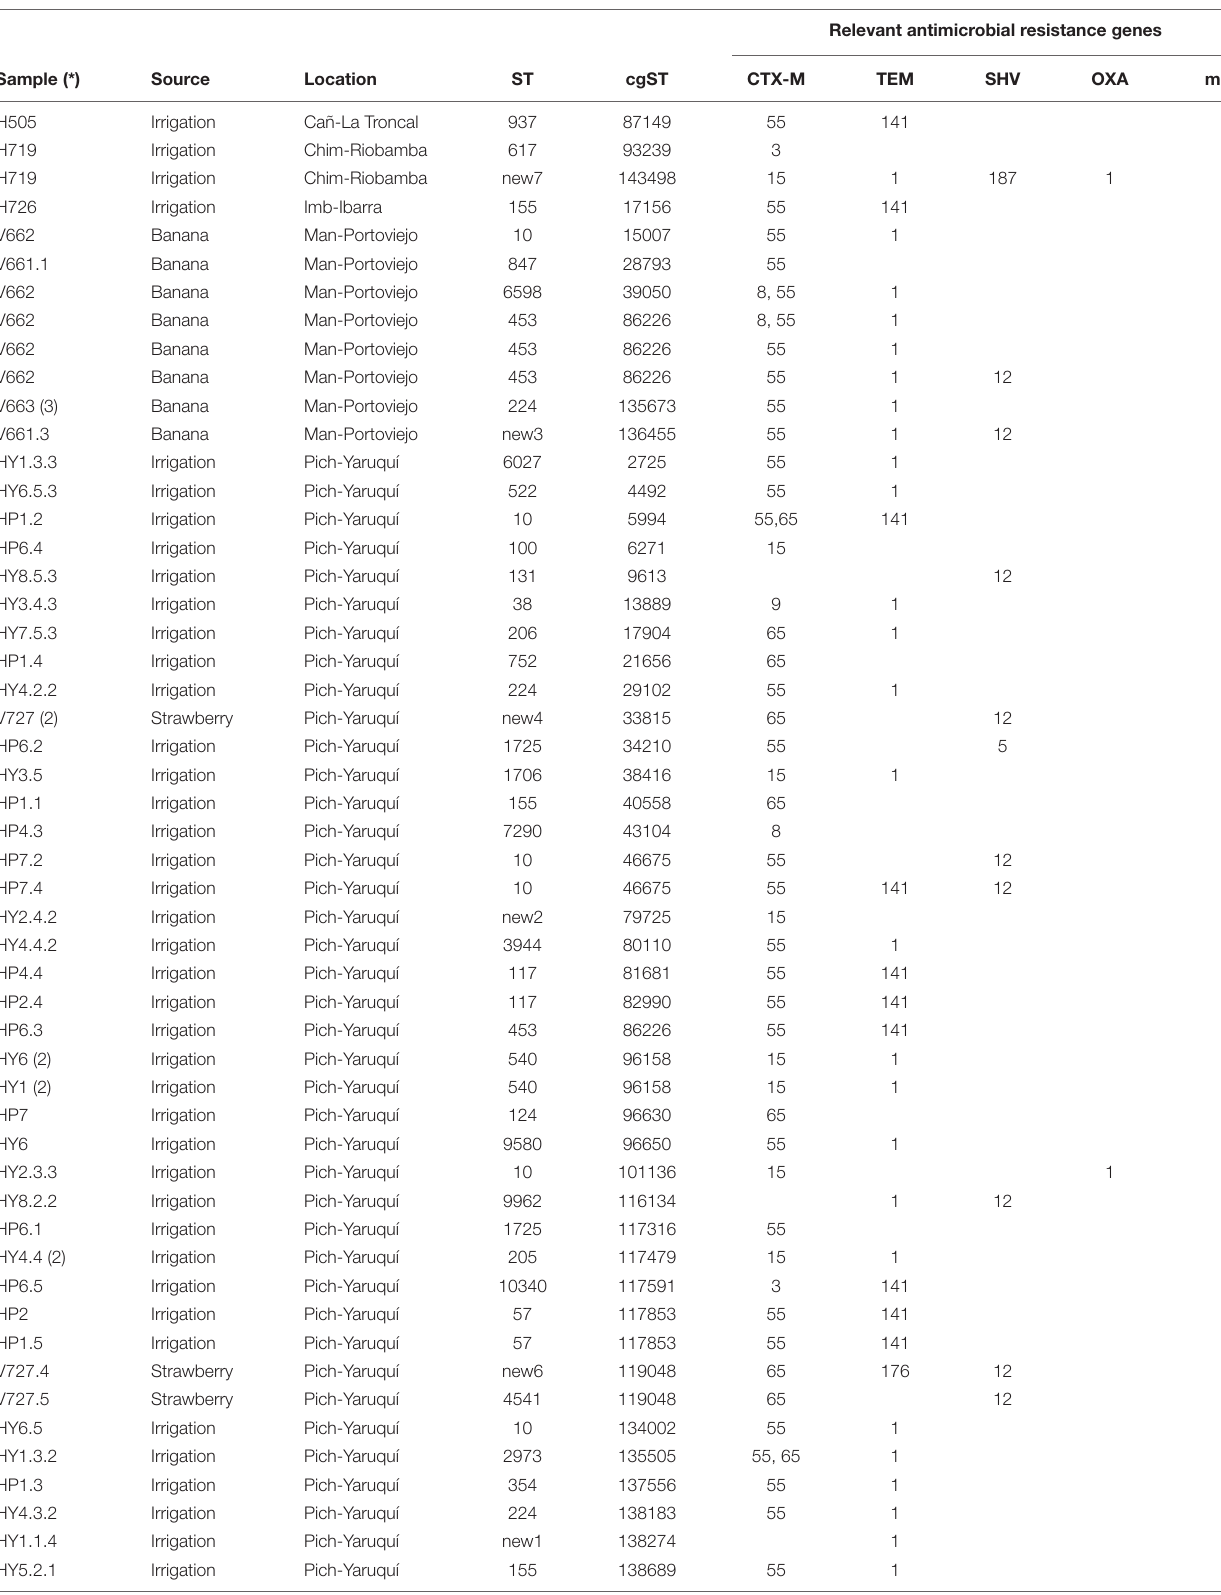
TABLE 4 | Source and genetic characteristics of ESBL- E. coli isolates from different sources in Ecuador.